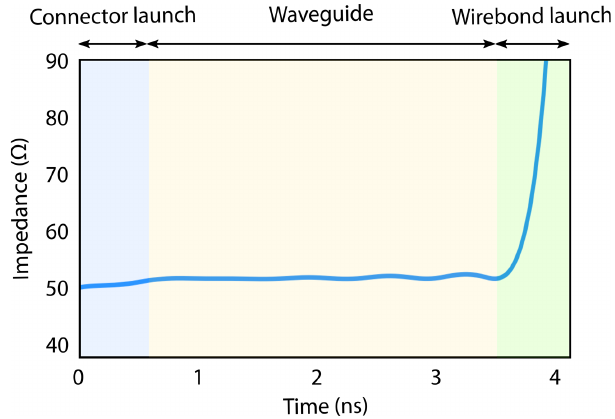
FIG. 7. Single-ended TDR measurement of the SMP-to- interposer connector transition. The reference plane of the con- nector is located at 0 ns. The wirebond launch is left open (no chip connected), resulting in a steep increase in impedance.